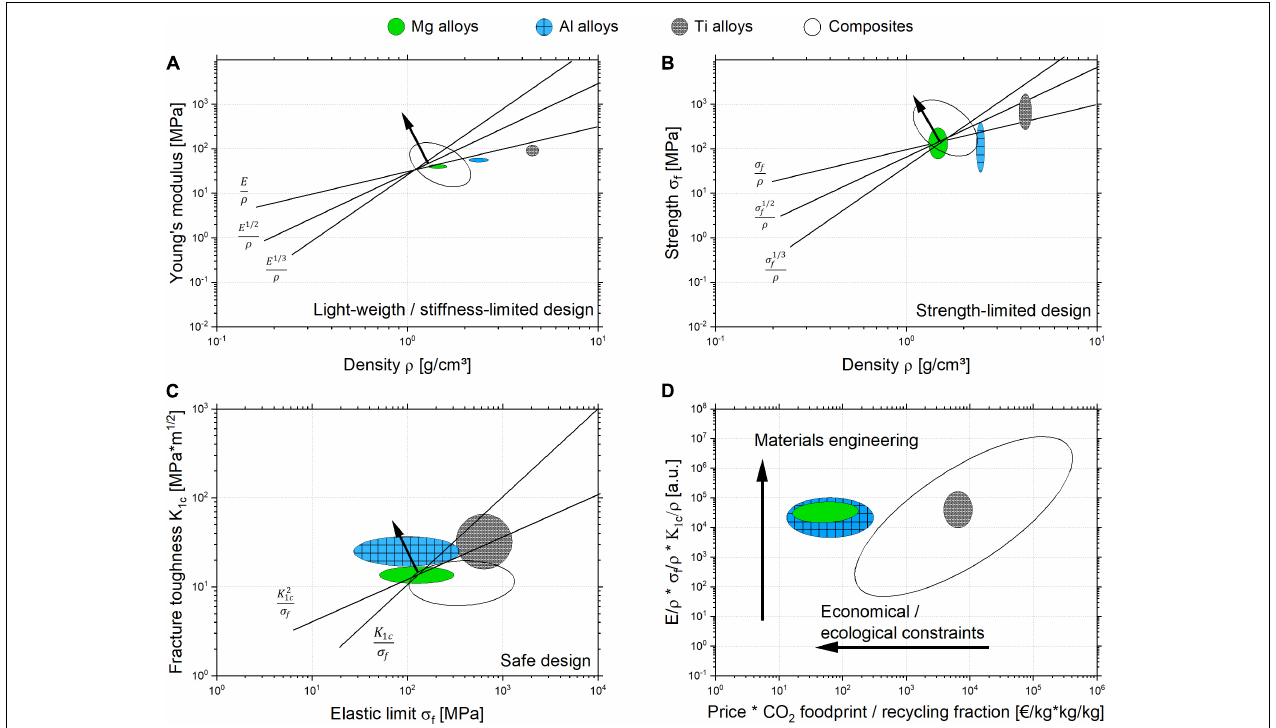
FIGURE 1 | Materials selection following Ashby for aerospace applications (based on Granta-design data). (A) Stiffness limited, (B) strength limited, and (C) safe design as proposed by standard structural design concepts, whereas the bottom-right diagram (D) shows the product of previous mechanical parameters vs. the product of non-physical properties like the material price, the carbon dioxide footprint and the reciprocal of recycling fraction.